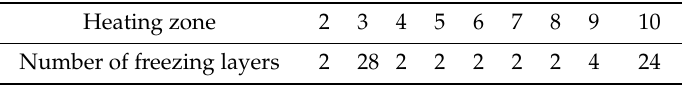
Table 7. Optimum number of freezing layers per heating zone.